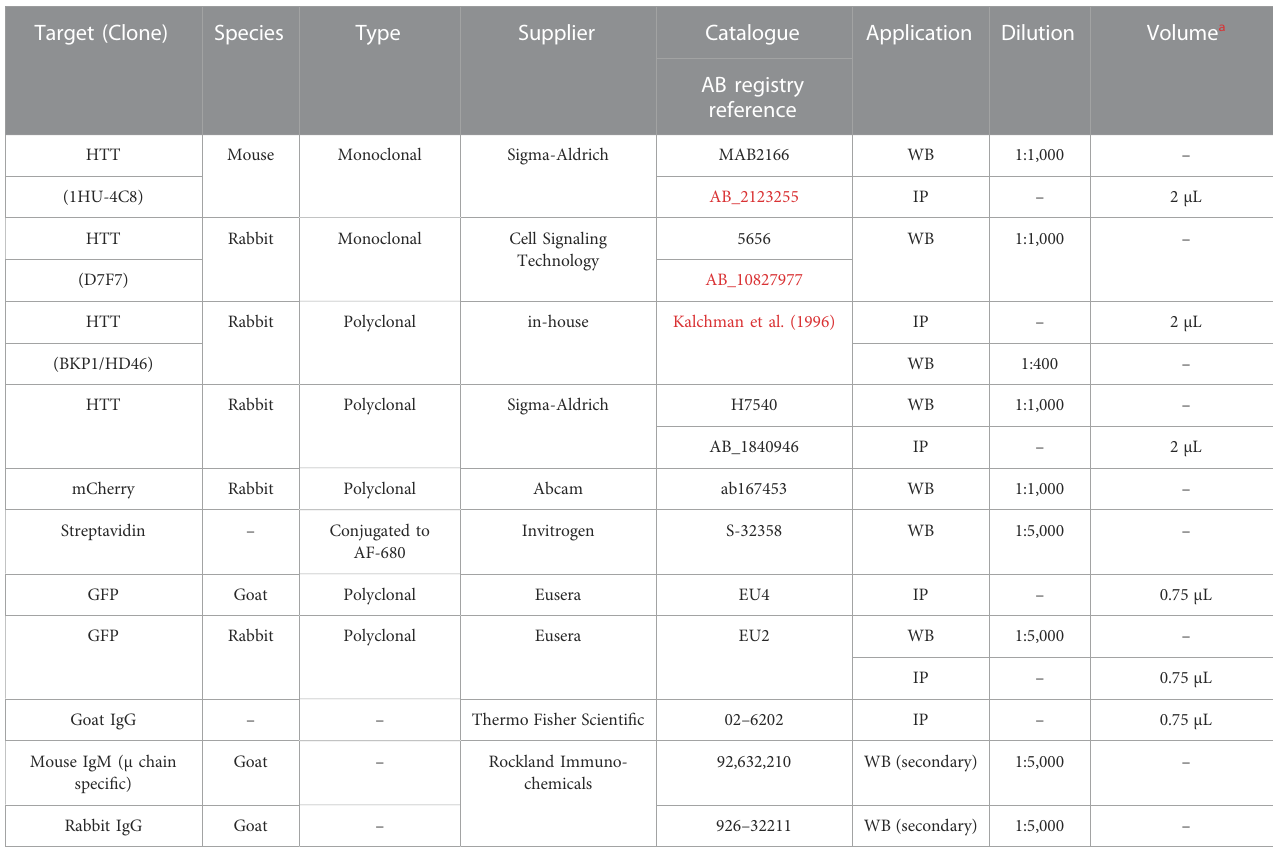
protein assay. HTT was immunoprecipitated from cell lysates by overnight incubation with Dynabeads Protein G and appropriate antibodies (Table 2). Bio-orthogonal click chemistry of alkyne- palmitate with biotin azide was performed on cell lysates, as previously described (Yap et al., 2010; Liao et al., 2021). The immunoprecipitated proteins were adjusted to 1% SDS and incubated with 100 mM tris (benzyltriazolylmethyl)amine (TBTA), 1 mM CuSO 4 , 1 mM tris-carboxyethylphosphine (TCEP) and 100 mM biotin azide (PEG4 carboxamide-6-Azidohexanyl biotin) at 37 ° C in darkness for 30 min. Total HTT and palmitoylated HTT were detected by western blot analysis.